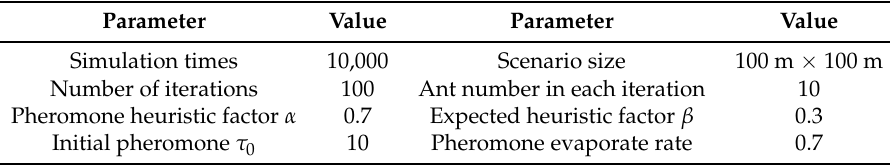
Table 3. Simulation parameters for ant colony optimization